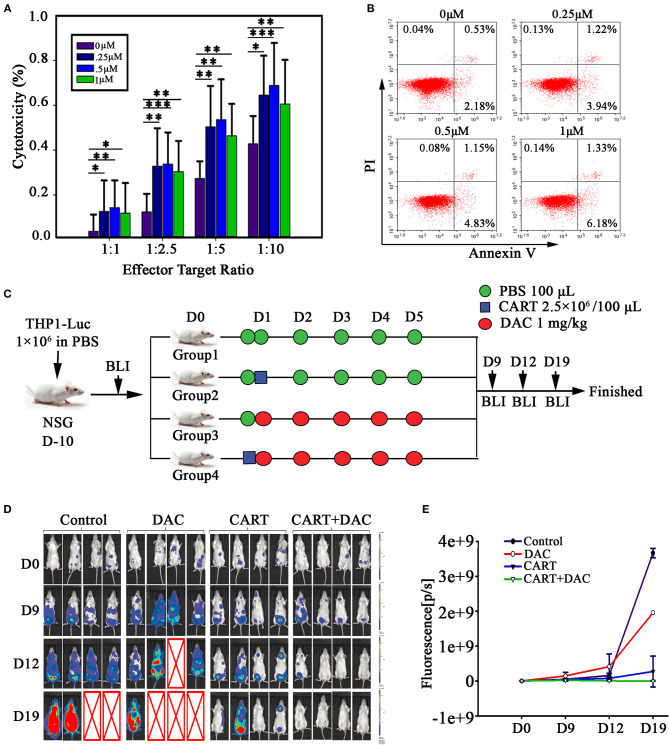
DAC enhances anti-leukemia activity of CD123 CAR-T cells in vitro and in vivo. (A) CD123 CAR-T cells, generated from four patients and three healthy donors, pretreated with different concentrations of DAC for 48 h, and then were co-cultured with THP1 cells at different E: T ratio (Effector: Target) for 4 h after drug wash-out. LDH release assay was used to detect the cytotoxicity of CD123 CAR-T cells. Three independent experiments were conducted. Mean ± SD. *p < 0.05, **p < 0.01, ***p < 0.001. (B) CD123 CAR-T cells were treated with different doses of DAC for 48 h and apoptosis was determined by flow cytometry. (C) NSG mice bearing AML tumor xenografts constructed by THP1-luciferase cells were randomized to receive one of the following treatments on 5 consecutive days: PBS, CD123 CAR-T cells (2.5 × 106), DAC (1mg/kg), or CD123 CAR-T cells (2.5 × 106) combined with DAC (1mg/kg). (D) Tumor signals were monitored with Lumina imaging on day 9, day12, and day 19. (E) The bioluminescence signal was measured as total photon flux normalized for exposure time and surface area and expressed in units of photons (p) per second per cm2 per steradian (sr) (n = 4 mice in each group).